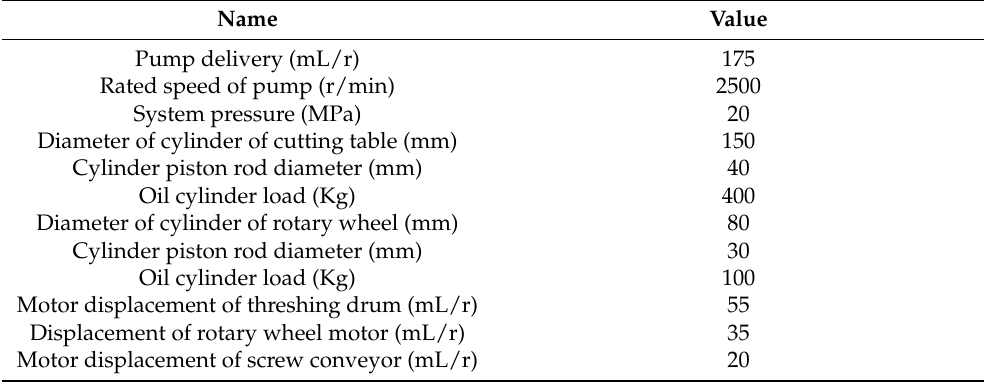
Figure 1. Hydraulic system simulation model of a combine harvester. Figure 2. Load analog signal.